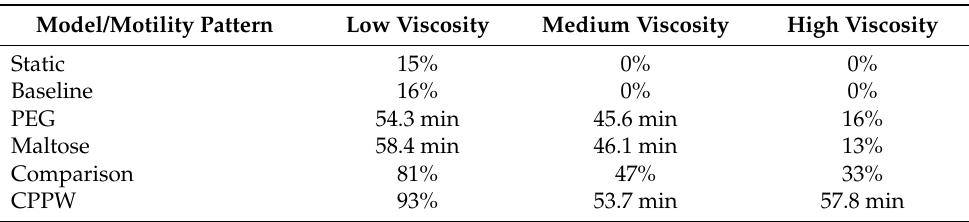
Table 6. Disintegration degree or disintegration time of the solid dosage form (tablet) for all mod- els/motility patterns at different fluid viscosities: % = degree of tablet disintegration φ at t = 60 min in %; min = time in minutes until complete tablet